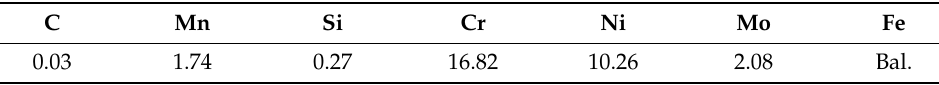
Figure 2. Experimental skew rolling mill and workpiece.